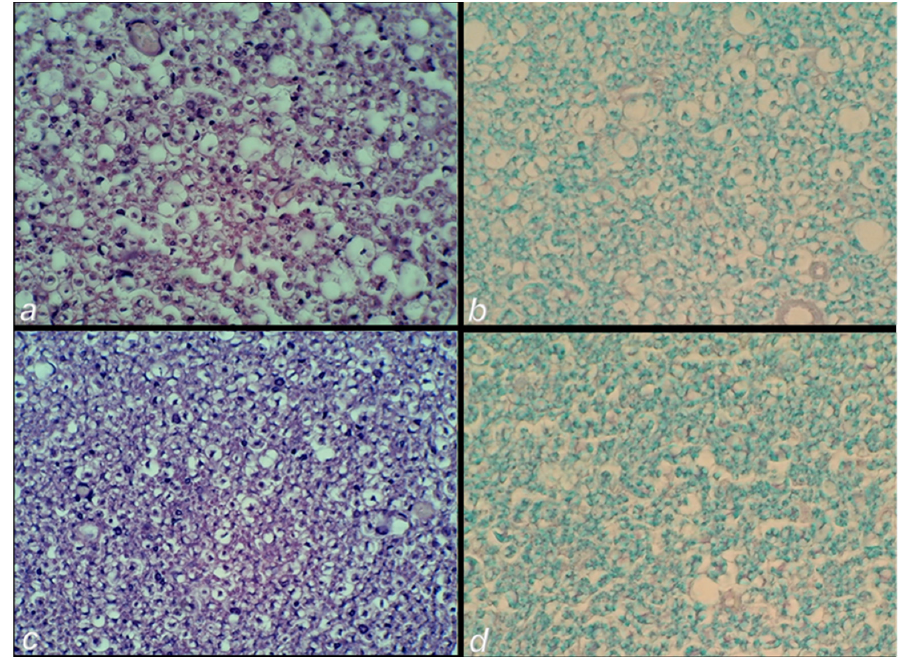
Figure 14. Post-injury day 30 with the therapy given since post-injury day 4. Neuropathological changes in the posttraumatic spinal cord in the lateral spinal column tract at the lesion site. ( a ) Control group edema and loss of neurons ( b ) loss of myelin fibers. ( c ) BPC 157 rats presented a minimal edema and ( d ) with preserved myelin fibers (HE ( a , c ) and Luxol fast blue staining ( b , d ); magnification 400×).